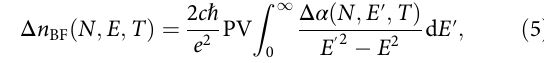
recombination via surface states with energy levels within the band gap 33, 43 . We verify that in our case, in the low-density – 2 regime — i.e., at a fl uence value of 45 μ J cm , or estimated plasma density of N 0 ≈ 4 · 10 18 cm – 3 — the time constant of the FC from the black curve in Fig. 3c. At plasma densities this low, the fast relaxation cannot be attributed to high order processes, as the characteristic times obtained through two-body and three-body solving Eq. (2); see Supplementary Note 2. Therefore, from the black curve in Fig. 3c, we can extract the effective mono- molecular coef fi cient, which is A eff = 1/ τ relax ≈ 4.0 × 10 11 s – 1 . The